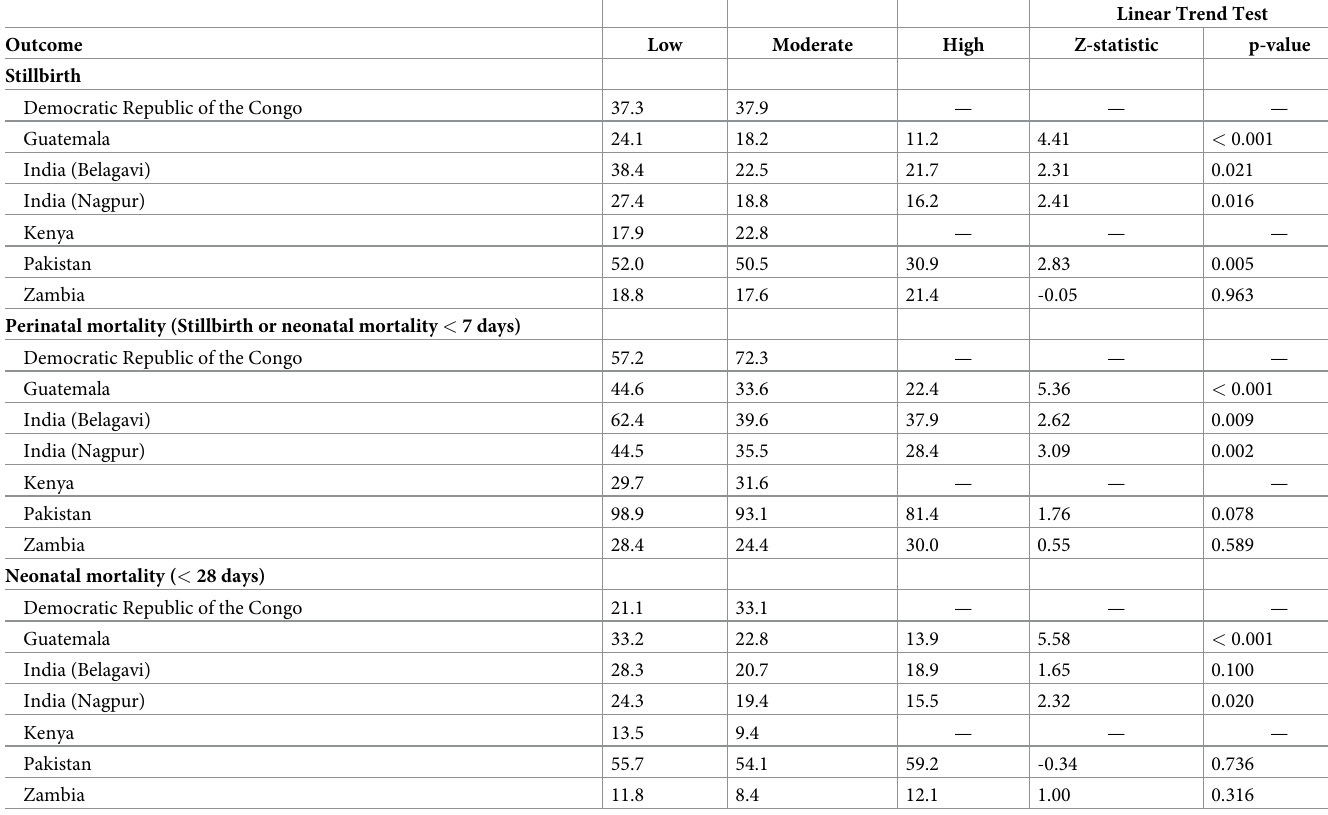
Table 2. Mortality rates per 1,000 by site and SES.